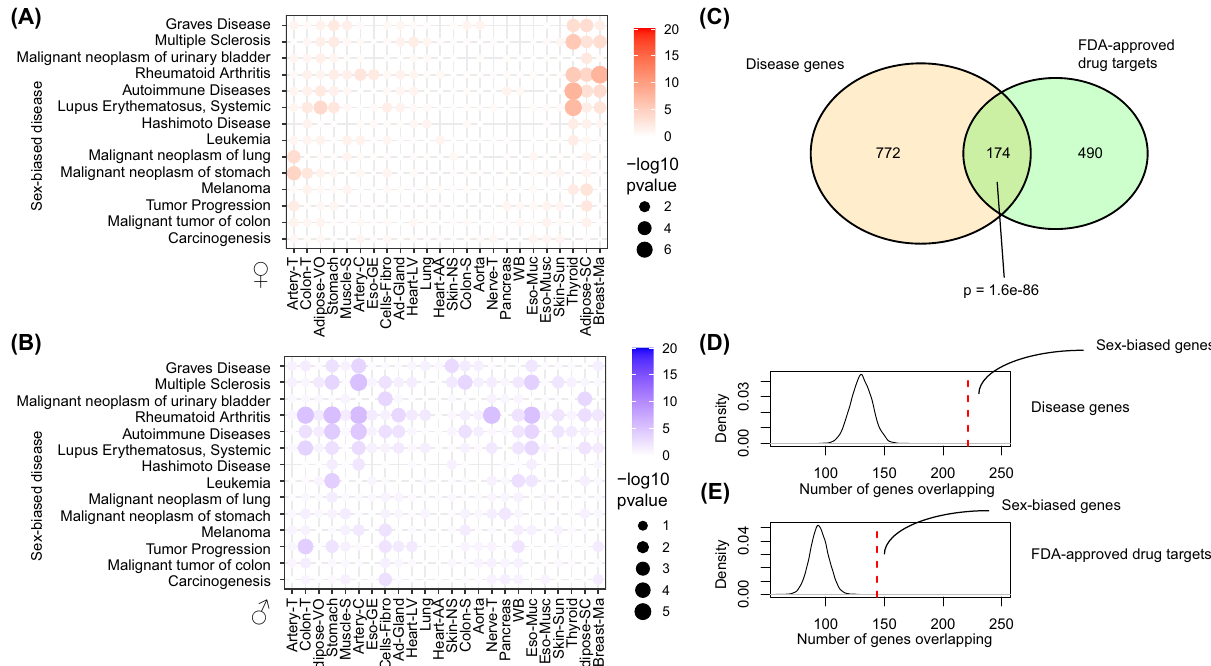
Figure 4. Importance of sex-biased co-expression exemplified by disease and FDA-approved drugs. ( A ) A heatmap shows the enrichment for female-biased genes over sex-biased disease such as autoimmune disease and non-reproductive cancer. Disease are shown in the rows, while the tissues are placed on the columns. Color and size of dot indicate –log10 p-value. ( B ) A heatmap shows the enrichment for male-biased genes over sex-biased disease such as autoimmune disease and non-reproductive cancer. Disease are shown in the rows, while the tissues are placed on the columns. Color and size of dot indicate – log10 p-value. ( C ) A venn-diagram highlights the overlap between disease-associated genes and gene targets of FDA-approved drugs. ( D ) A density-plot of amount of genes overlapping shows the permuted distribution of random genes and their overlap with disease genes. The vertical line highlights the observed value for sex-biased genes. ( E ) A density-plot of amount of genes overlapping shows the permuted distribution of random genes and their overlap with FDA-approved drug target genes. The vertical line highlights the observed value for sex-biased